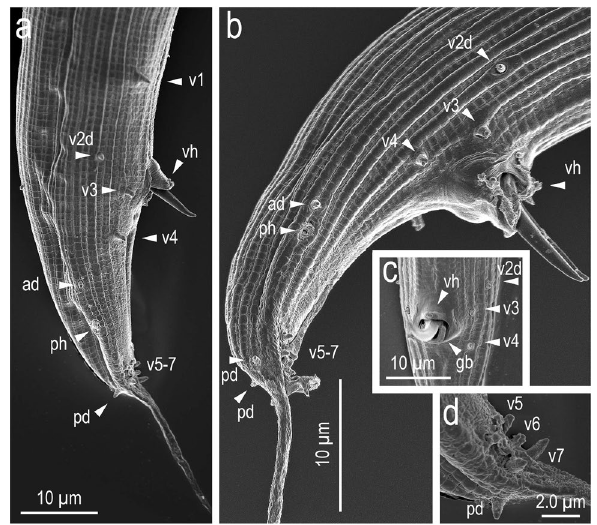
Figure 9. Scanning electron micrographs of male tail characters. ( a,b ) Entire tail in right lateral view of two different individuals; ( c ) ventral view of cloacal region; ( d ) right subventral view of posterior region. Labels are as follows: ph = phasmid; v + number, ad, pd = genital papillae according to the terminology by Sudhaus & Fürst von Lieven 1 ; vh = ventral hook (ventral single papilla). Tail tip is out of the range of the micrograph in Fig. 9a.